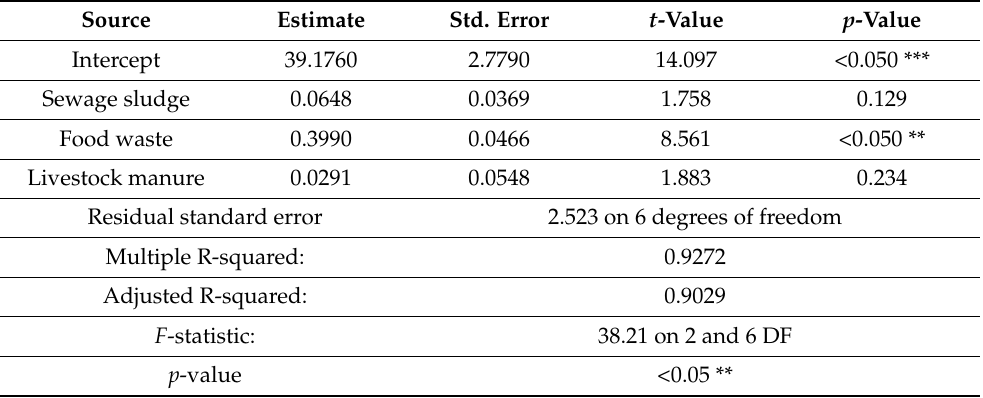
Table 9. Volatile solids (VS) removal rate from multiple regression.